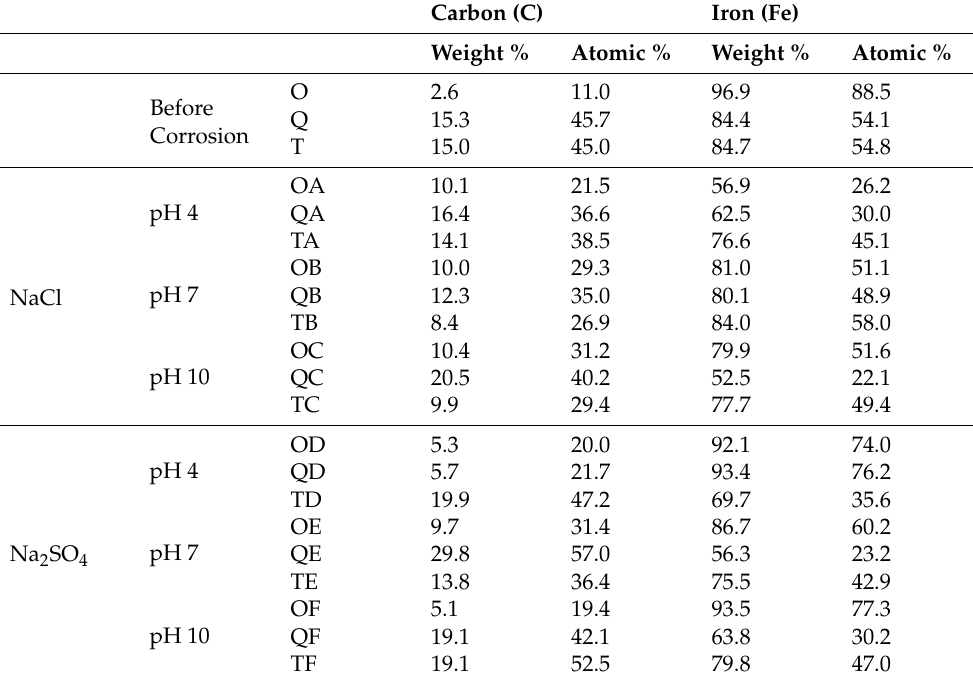
Figure 12. SEM images of O, Q, and T samples before and after exposure to corrosive Cl- free environments at pH 4, 7, and 10. Table 8. SEM-EDS Analysis of O, Q, and T for Cl- rich and Cl- free